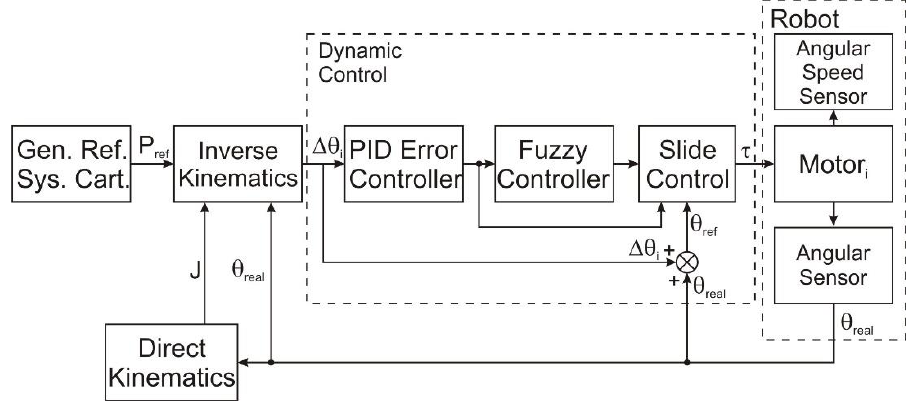
Figure 7. The dynamic control scheme.